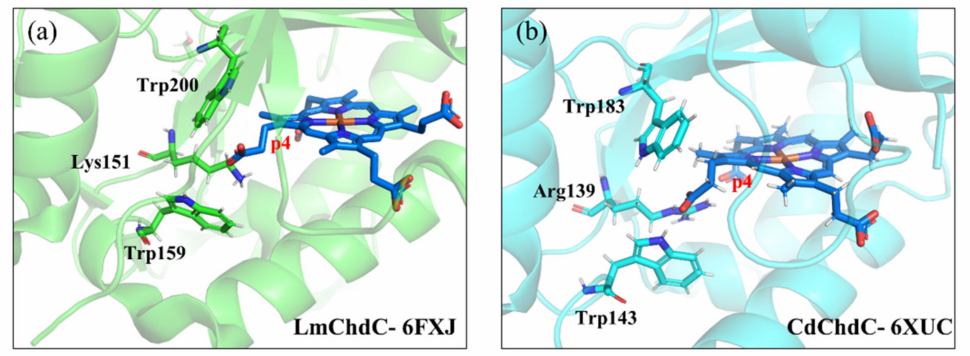
Figure 10. Trp–Lys–Trp portal of ( a ) LmChdC and ( b )